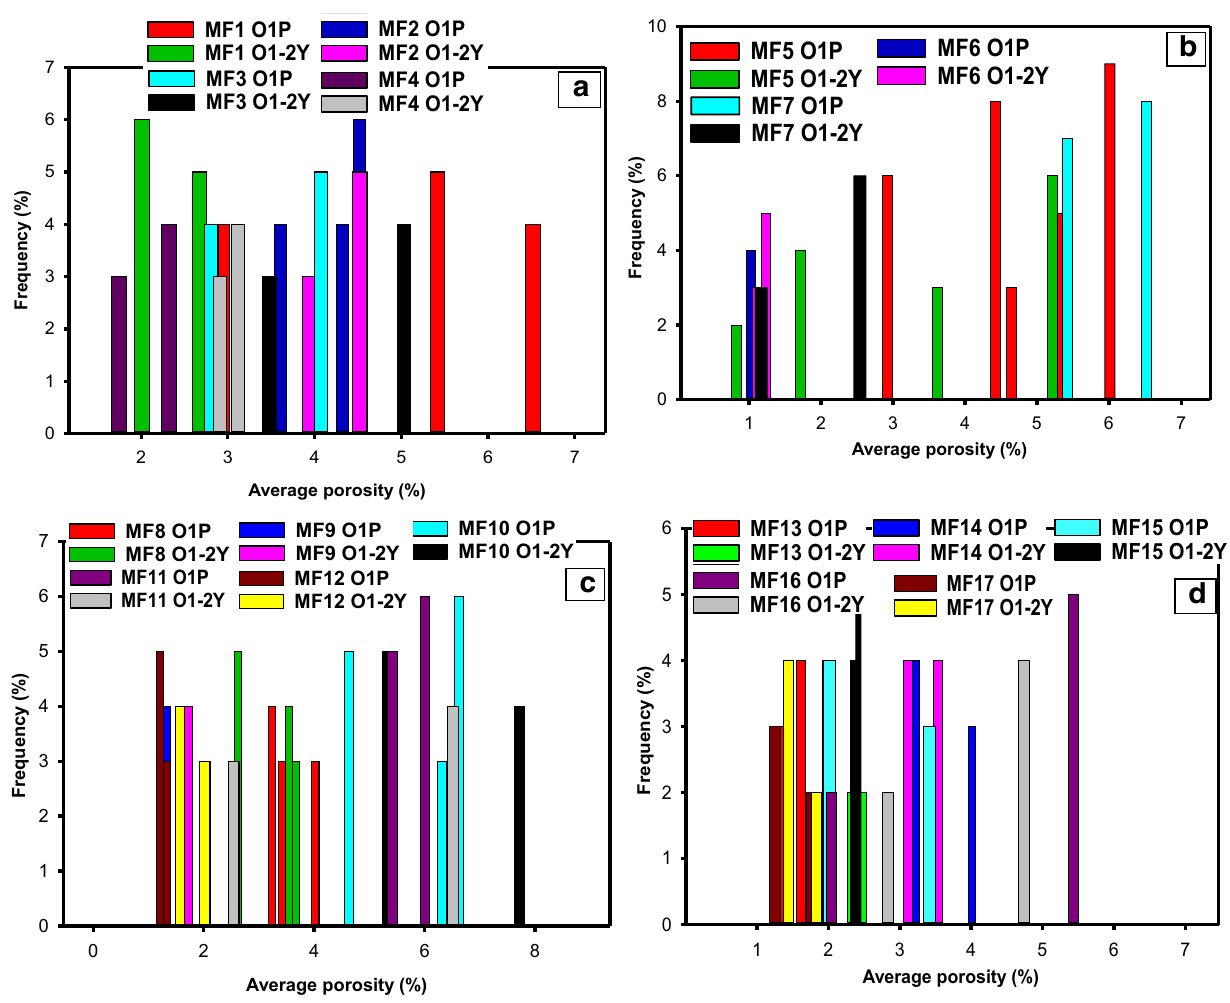
Fig. 10 Frequency distribution of average porosity and average per- meability in the reef and shoal microfacies (MF-1 to MF-17) of the Lower Ordovician Formations in the Tazhong Uplift: a frequency his- togram of average porosity of MF-1 to MF-4 in the O 1 P and O 1–2 Y; b frequency histogram of average porosity of MF-5 to MF-7 in the O 1 P and O 1–2 Y; c frequency histogram of average porosity of MF-8 to MF-12 in the O 1 P and O 1–2 Y; d frequency histogram of average porosity of MF-13 to MF-17 in the O 1 P and O 1–2 Y; e frequency histo- gram of average permeability of MF-1 to MF-4 in the O 1 P and O 1–2 Y; f frequency histogram of average permeability of MF-5 to MF-8 in